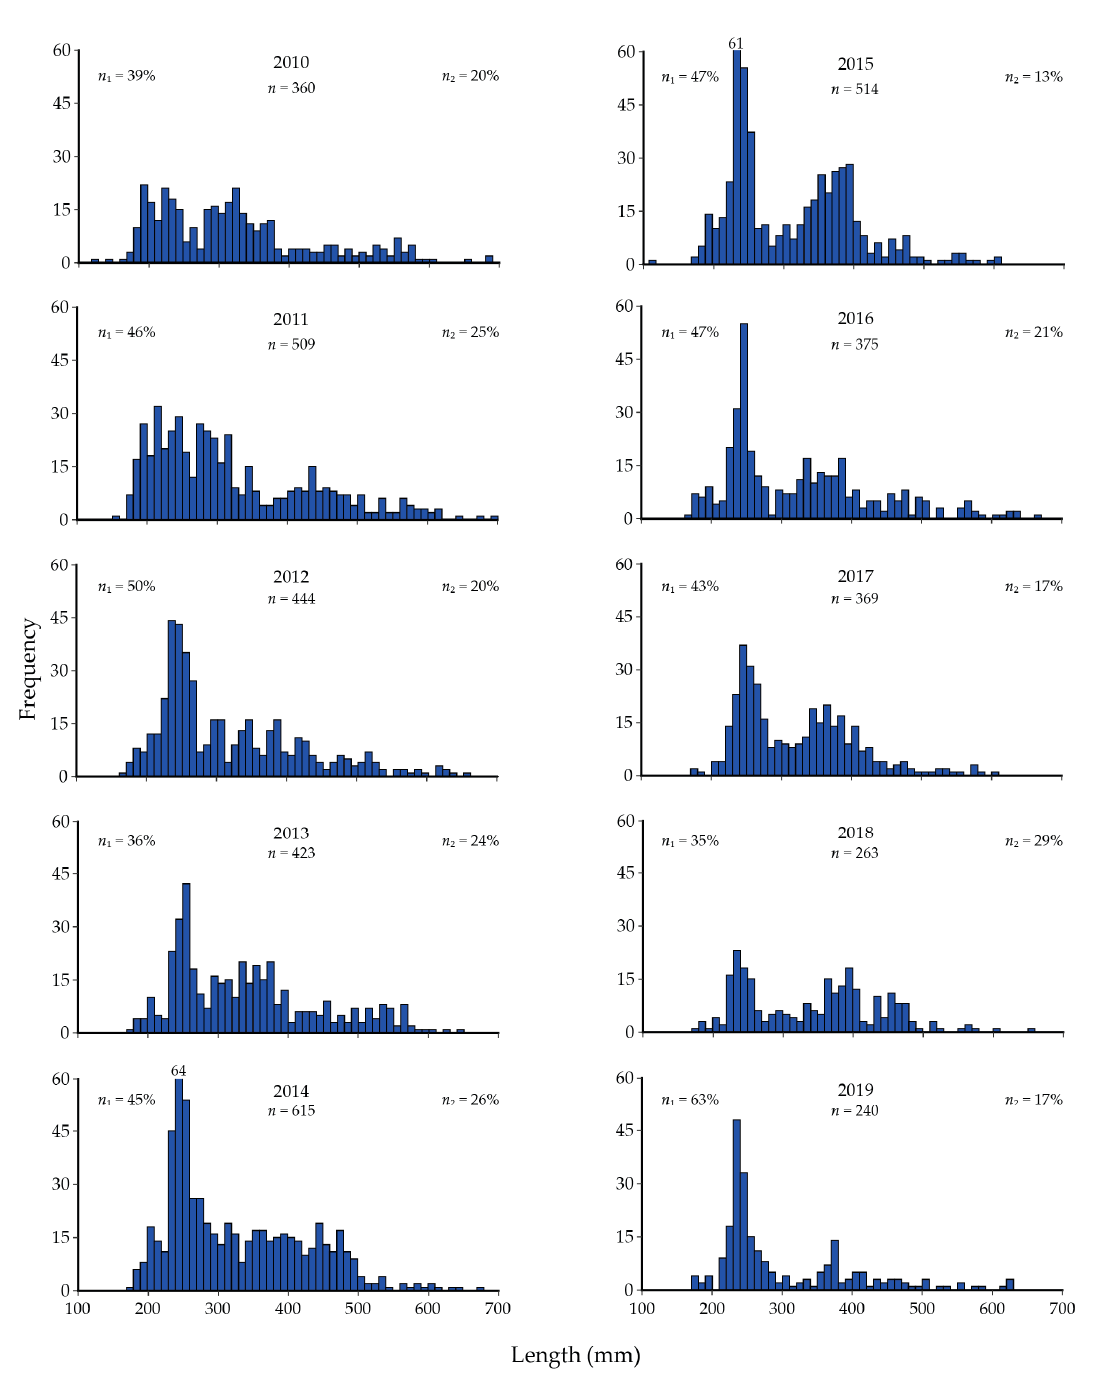
Figure A5. Length-frequency distributions of lake trout sampled during annual long-term gillnetting assessments on Yellowstone Lake with total number sampled ( n ), percentage ≤ 280 mm ( n 1 ), and percentage ≥ 400 mm ( n 2 ) each year, 2010–2019.